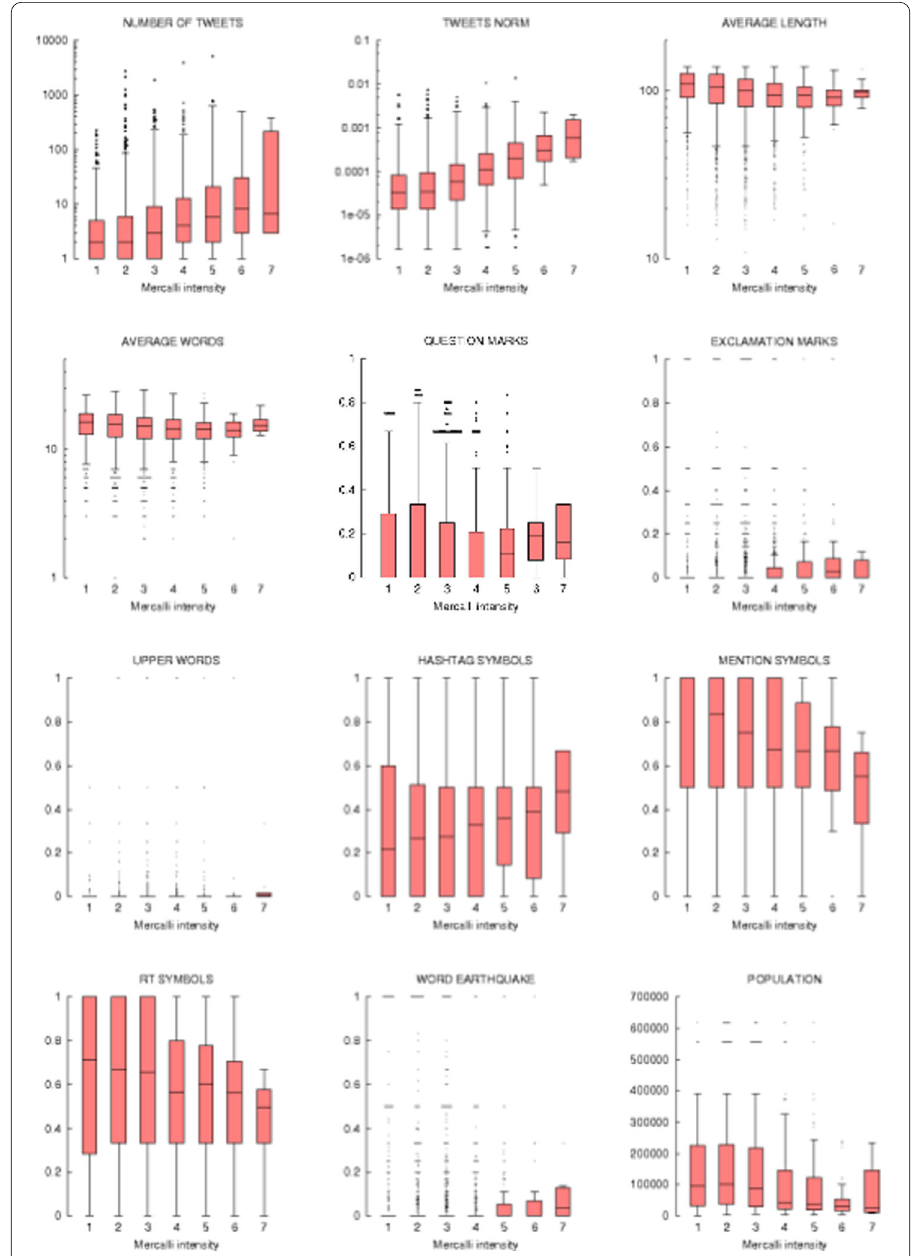
Figure 5 Boxplots for each feature of our dataset. Boxplots for each feature in relation to Mercalli intensity values at municipality level granularity. Points outside each boxplot represent outliers. Some plots are in logarithmic scale to improve the visualization of the data